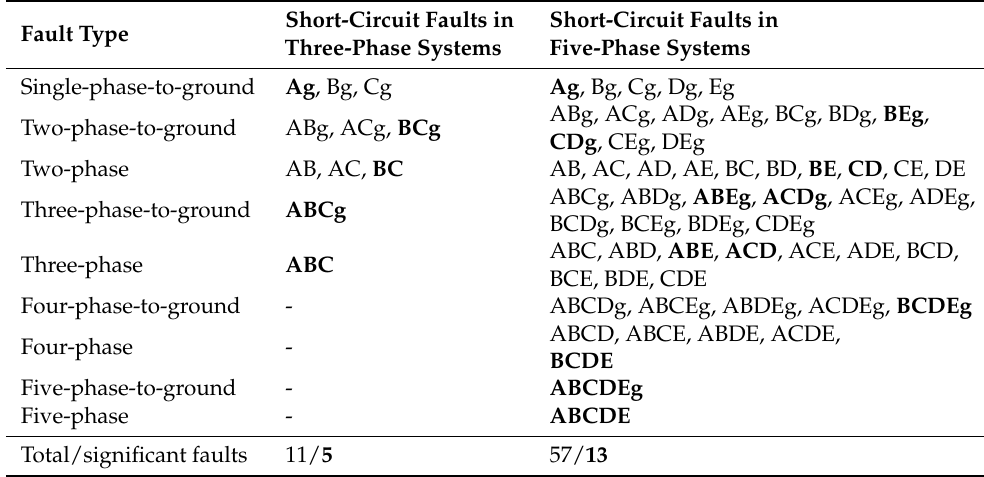
Table 1. Classification of short-circuit faults for three-phase and five-phase electrical